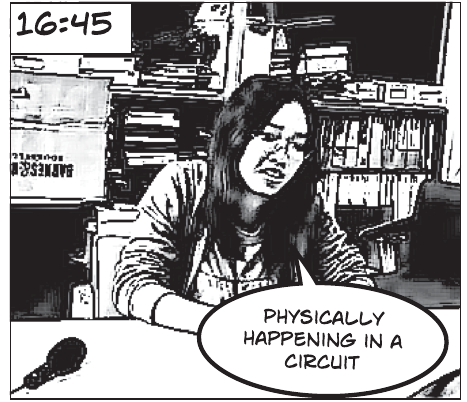
FIG. 3. The panel shows the negative emotion in Judy ’ s facial expressions in episode 2 as she says “ physically happening in a circuit.